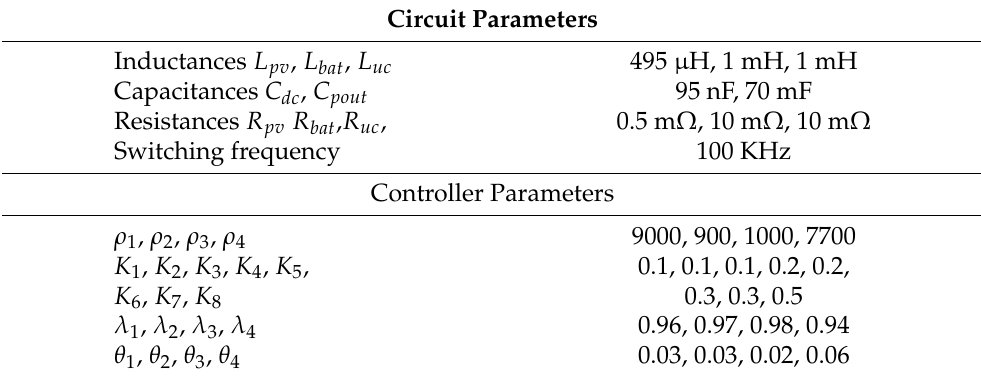
Table 3. Simulation parameters.